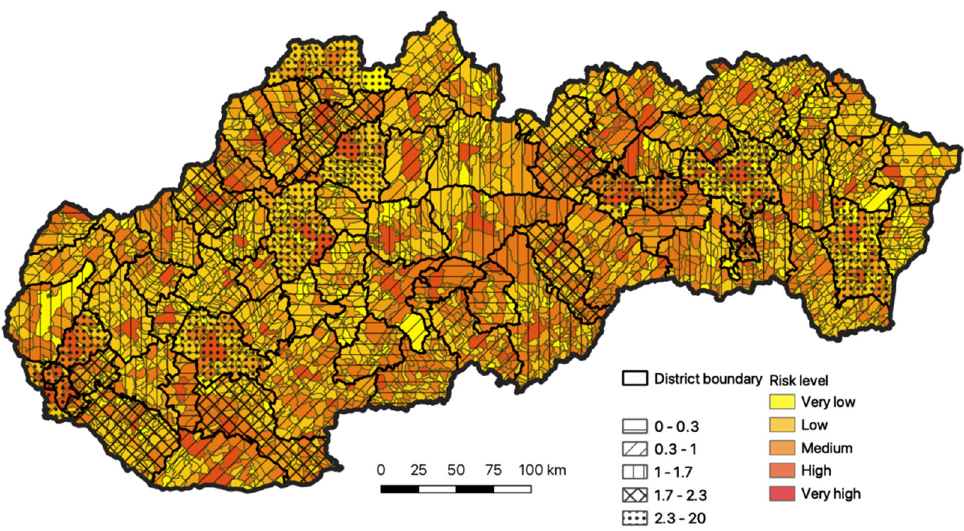
Figure 7. Comparison of the total evaluation of risk with the actual recorded status, as of 31 July 2020. Source: Statistical Office of the Slovak Republic, 2020.